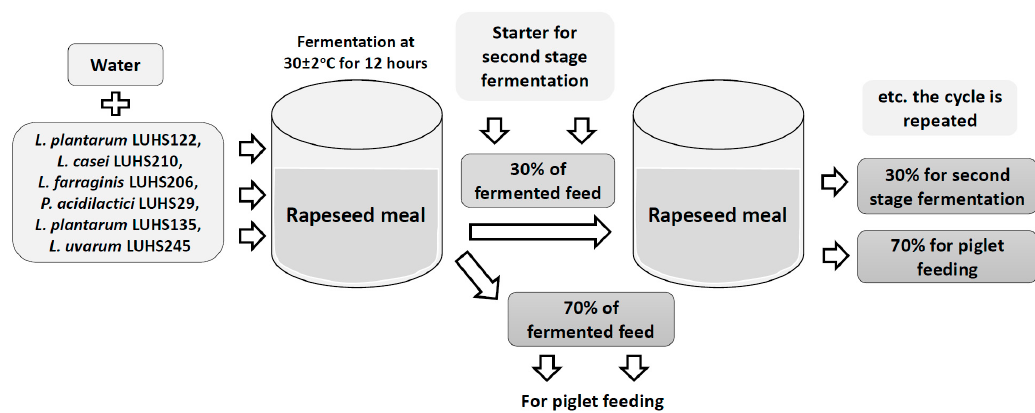
Figure 1. Scheme of fermented feed preparation.